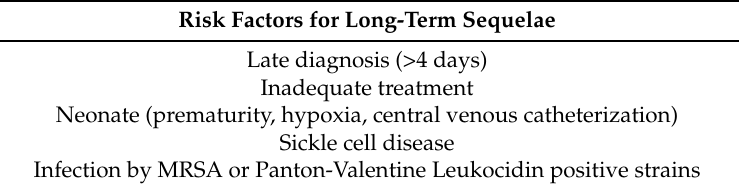
Table 1. Risk factors for long term